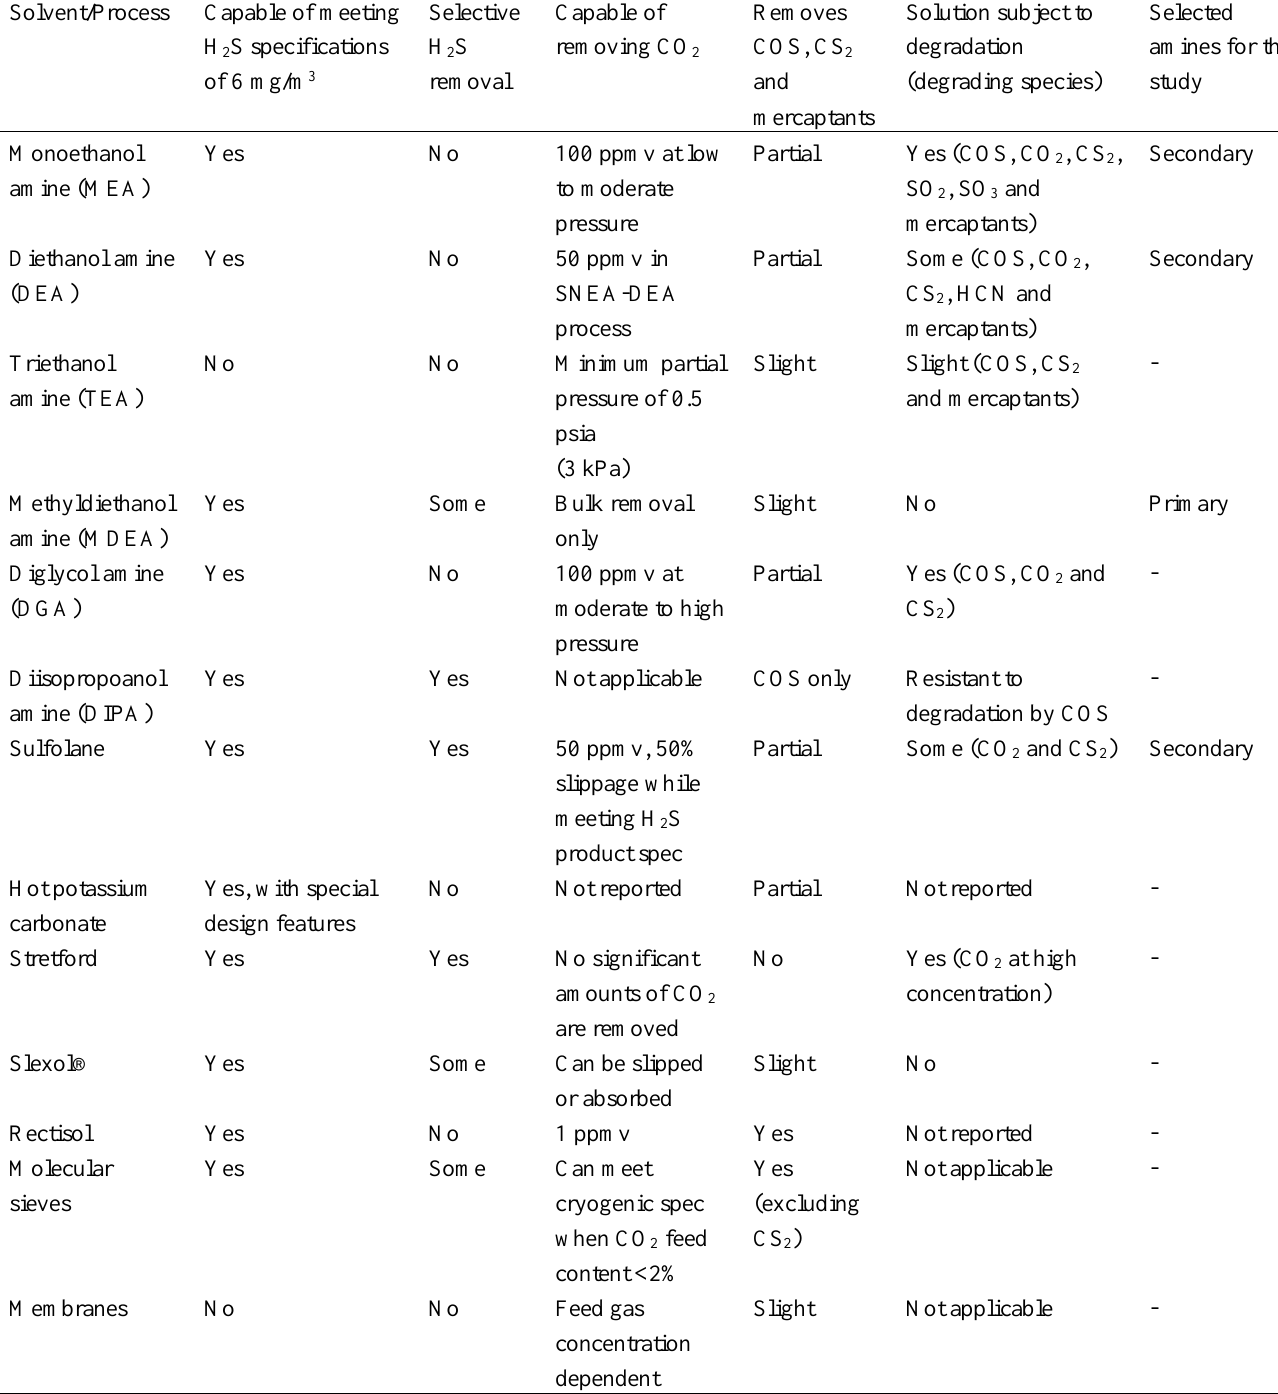
Table 2 Summary of NG chemical treatment processes and selection criteria